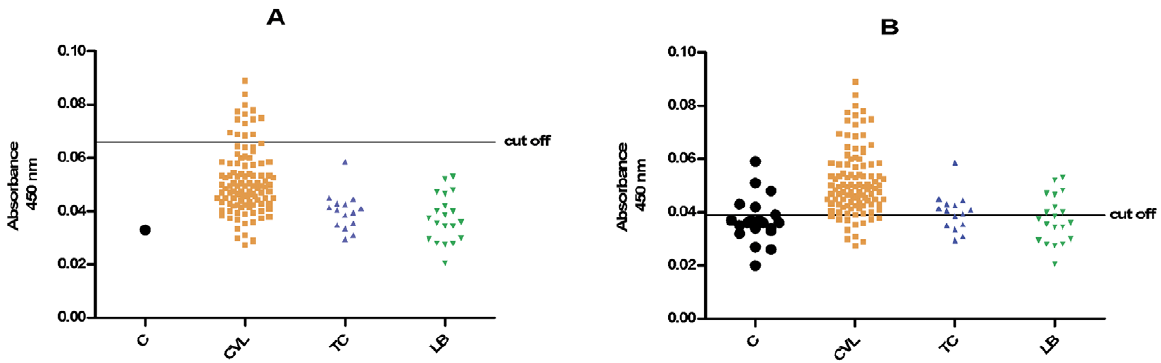
Figure 2. Comparison of ELISA reactivity of canine sera assessed by EIE-LVC kit. ELISA was performed in different groups of dogs (C, control group, n=1, given by the kit; CVL, L. infantum group, n=107; TC, T. cruzi group, n=15; LB, L. braziliensis group, n=20). In A, cut off was performed according to the manufacturer; in B, it was performed using ROC curve with serum samples from control group.